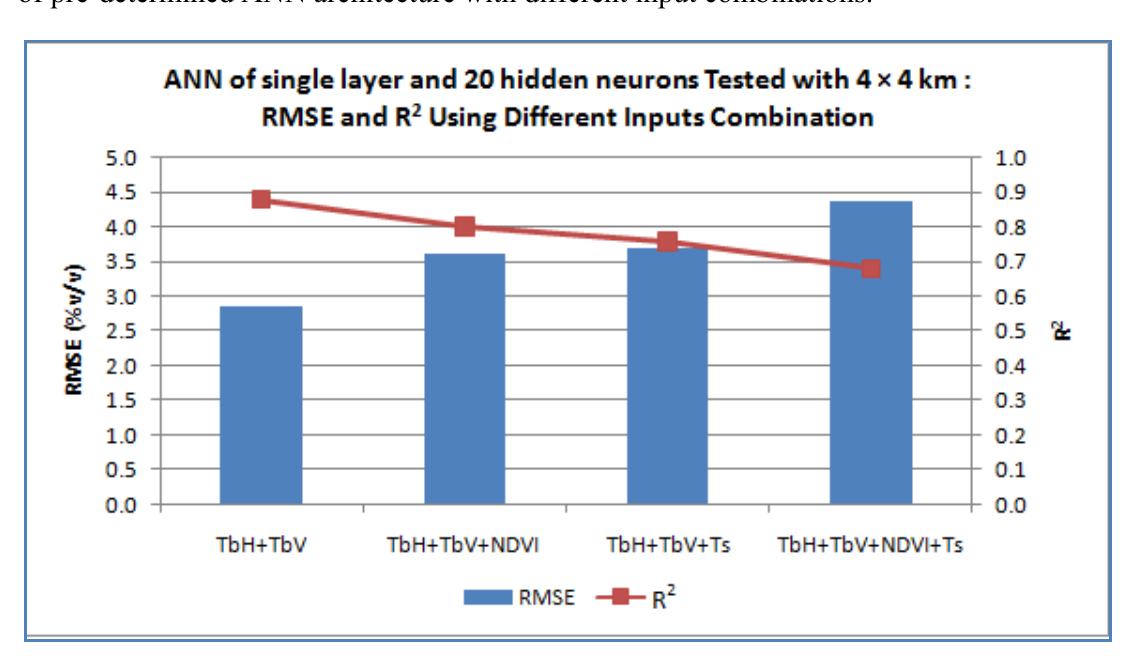
Figure 4 . The results obtained for the 4 km × 4 km sub-grid when using the trained ANN of pre-determined ANN architecture with different input